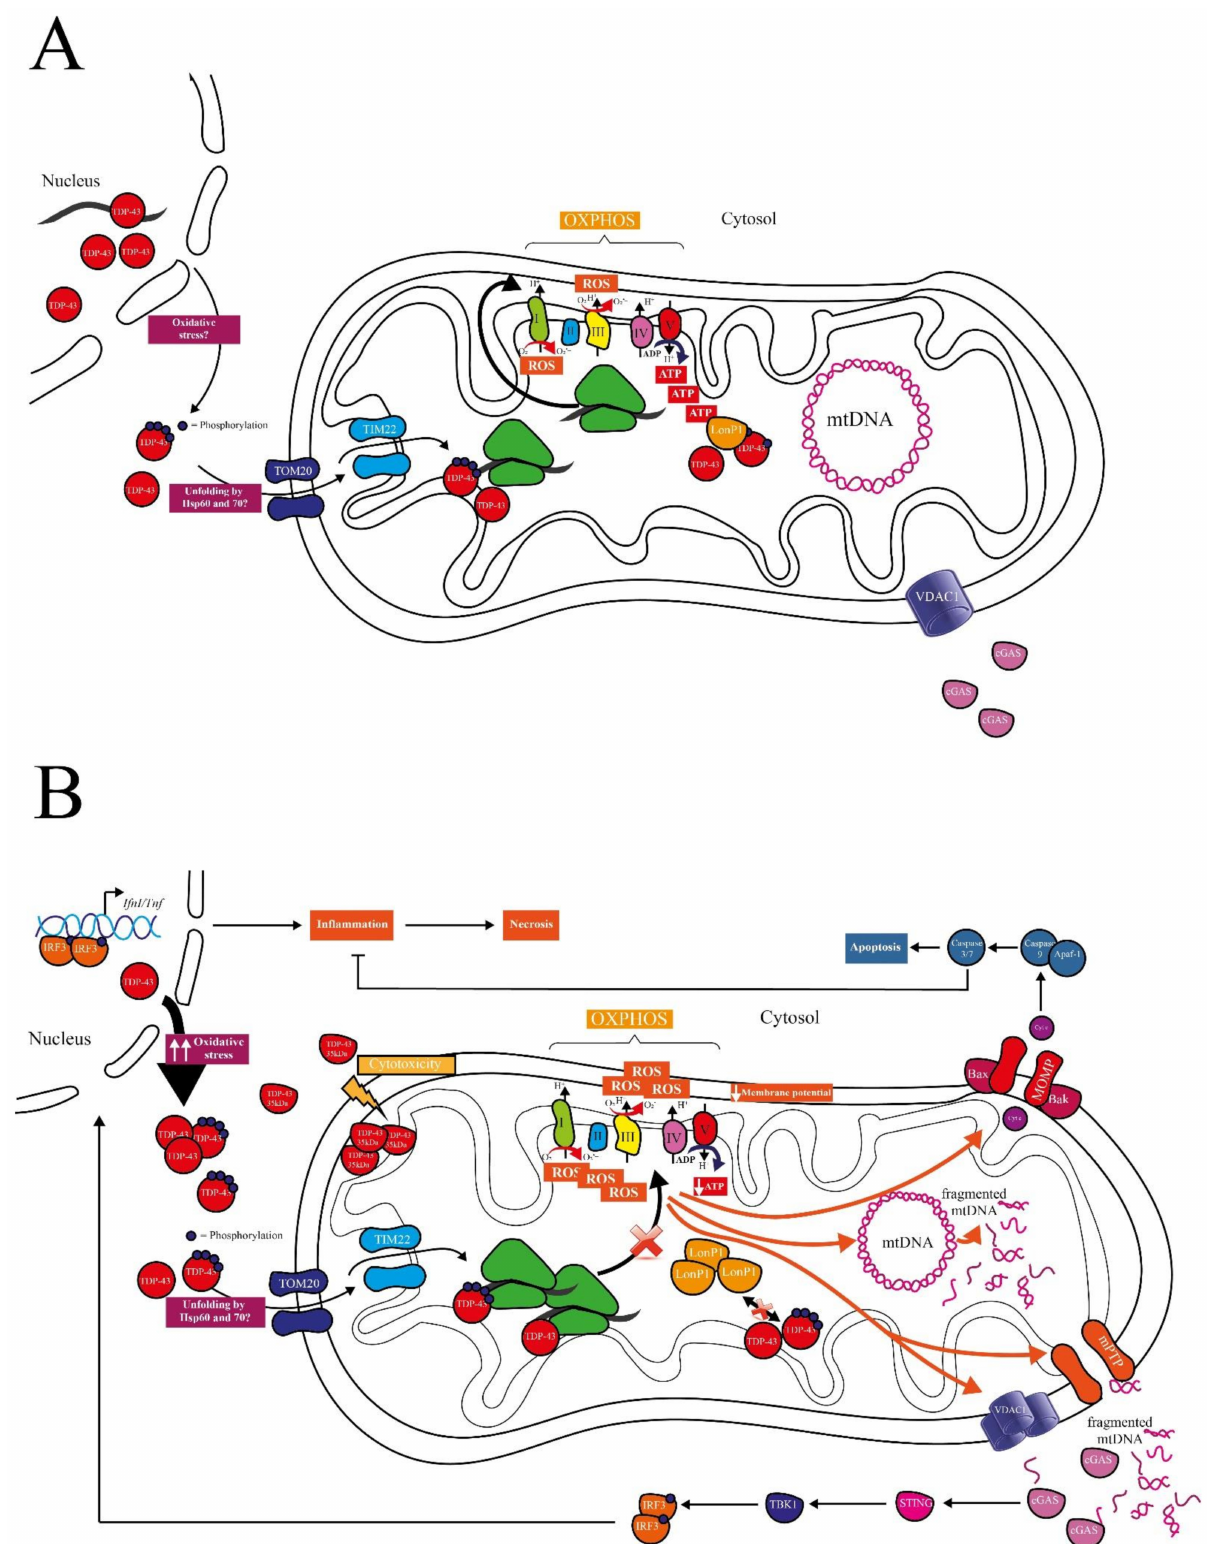
Figure 1. Potential physiological and pathophysiological roles of TDP-43 in mitochondrial function and cell death. ( A ) Phys- iological roles: Oxidative stress triggers the export of nuclear TDP-43 into the cytosol. Exported and newly synthesized cytosolic TDP-43 might be phosphorylated. Upon unfolding by Hsp60 or Hsp70, phosphorylated and unphosphorylated TDP-43 might be imported into mitochondria through TOM20 and TIM22. TDP-43 localizes in the matrix-facing part of the mitochondrial inner membrane (MIM), where it might regulate expression of OXPHOS components. Surplus,